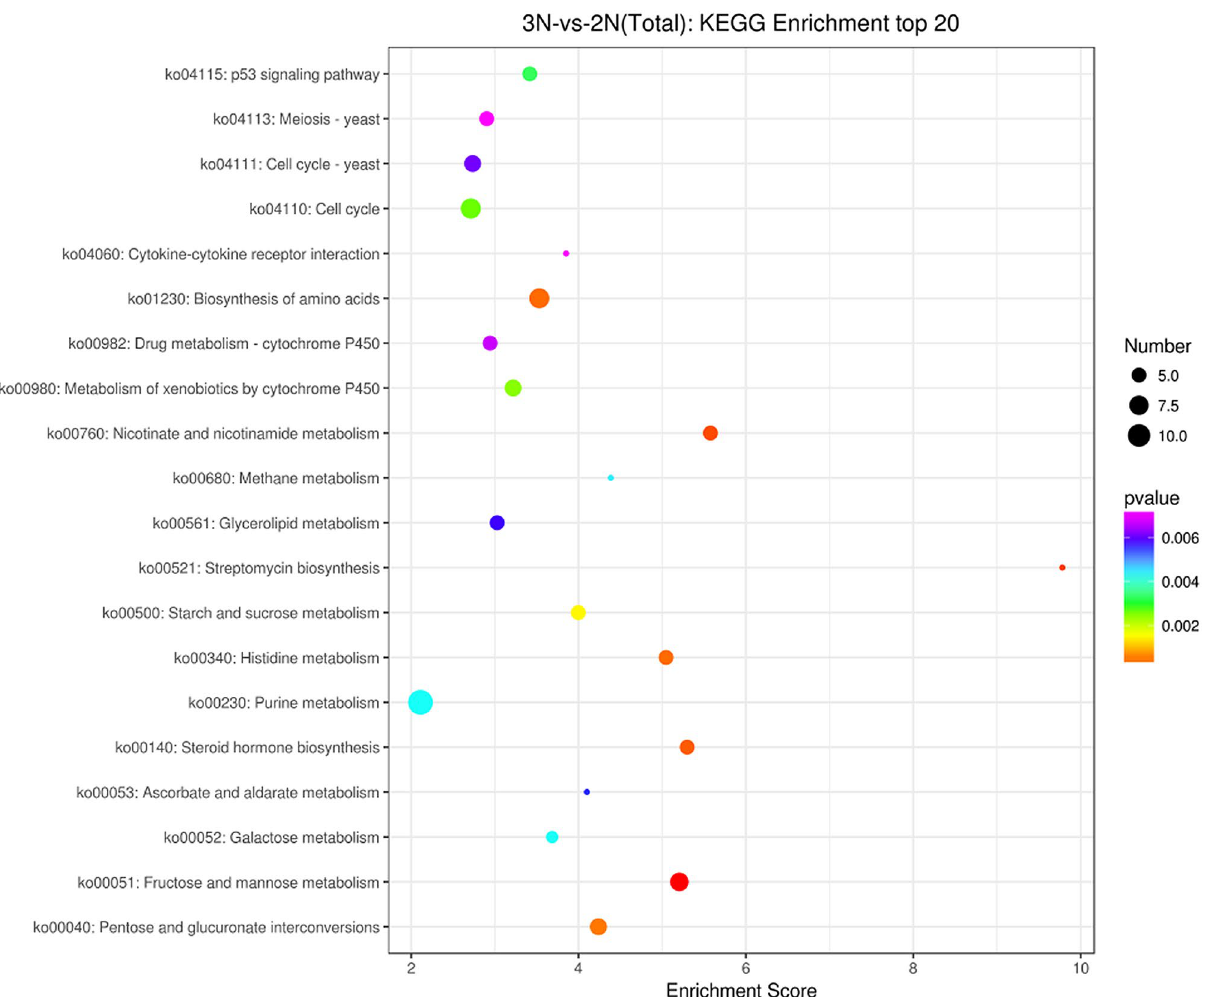
Figure 4. Top 20 differentially expressed genes in the KEGG enrichment analysis. The X-axis is the enrichment score. The larger the bubble, the more differential protein-encoding genes contained in the item. The color of bubbles changes from purple to blue to green to red, with the smaller p -value corresponding to greater significance.